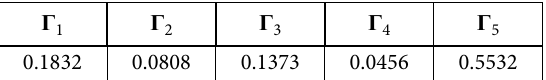
Table 2. The weight of the